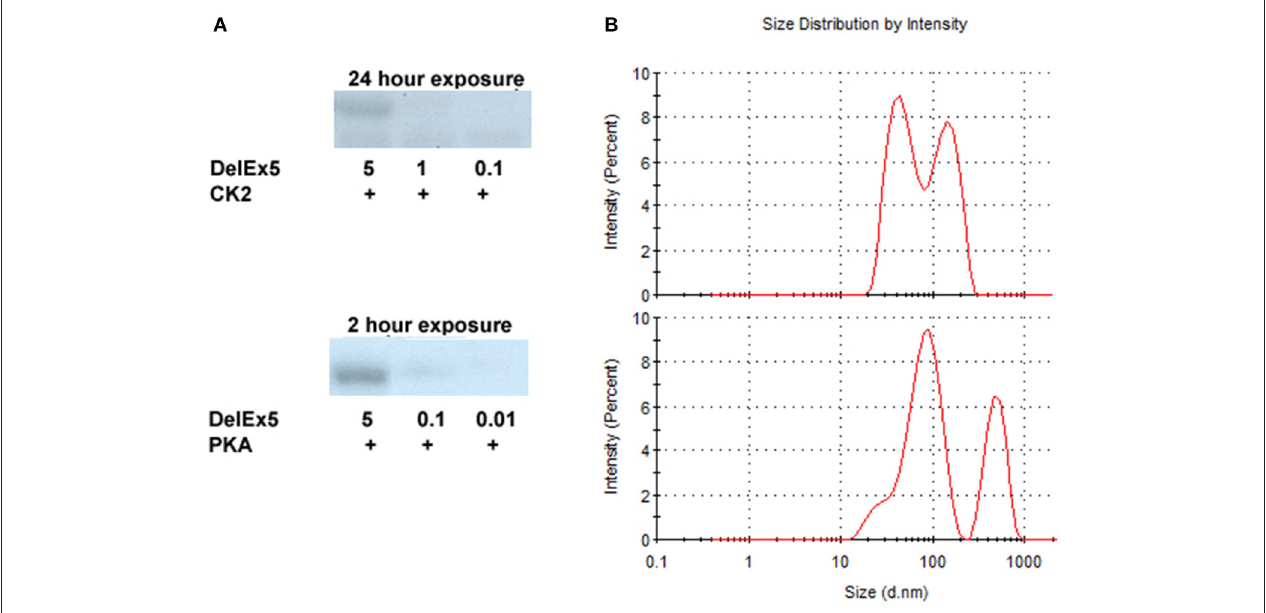
FIGURE 2 | Autoradiography of DelEx5 (0.01–5 µ g) phosphorylated with CK2 and PKA (A) . Dynamic light scattering of AMBN-WT (upper panel) and AMBN-WT incubated with 5% glycerol (lower panel) (B) . In these experiments the phosphorylation of DelEx5 by CK2 required an exposure time of 24 h to match a 2 h exposure of DelEx5 phosphorylated by PKA.